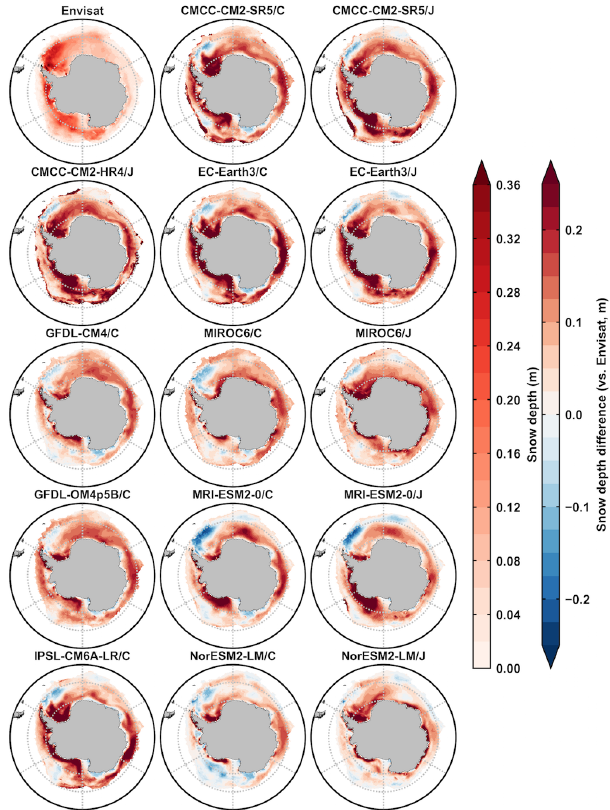
Figure A7. The 2003–2007 February mean Arctic snow depth from Envisat data (first picture, m) and snow depth differences between model outputs and Envisat data (m). The second and third columns are from the five OMIP1 and OMIP2 model outputs of CMCC- CM2-SR5, EC-Earth3, MIROC6, MRI-ESM2-0, and NorESM2- LM, respectively.